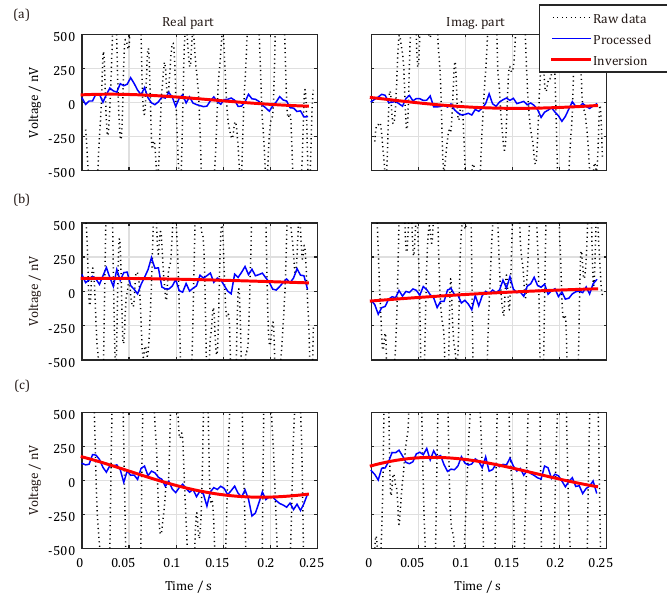
Figure 10. Data processing results of the field measured UMRS signal. The black dashed lines are the raw data, the blue lines are the processed data, and the red ones are the forward-calculated signals from the inversion result model. ( a ) q = 0.59 As; ( b ) q = 0.81 As; ( c ) q = 1.03